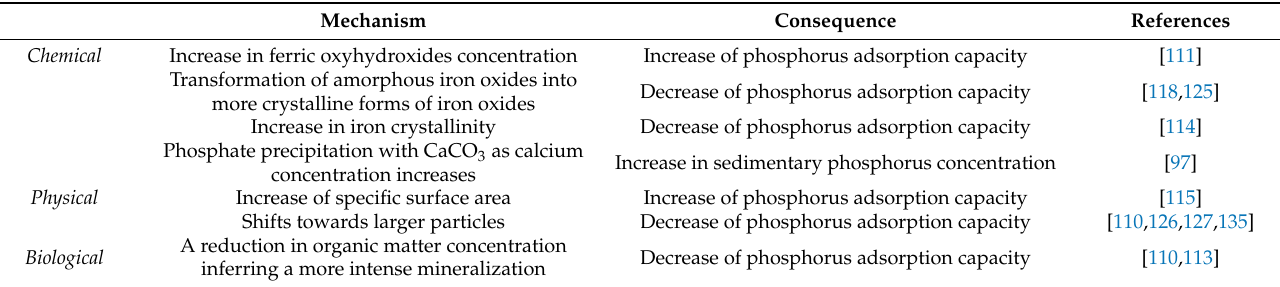
Table 1. Effects of sediment air drying on phosphorus dynamics reported by the literature in inland aquatic ecosystems.